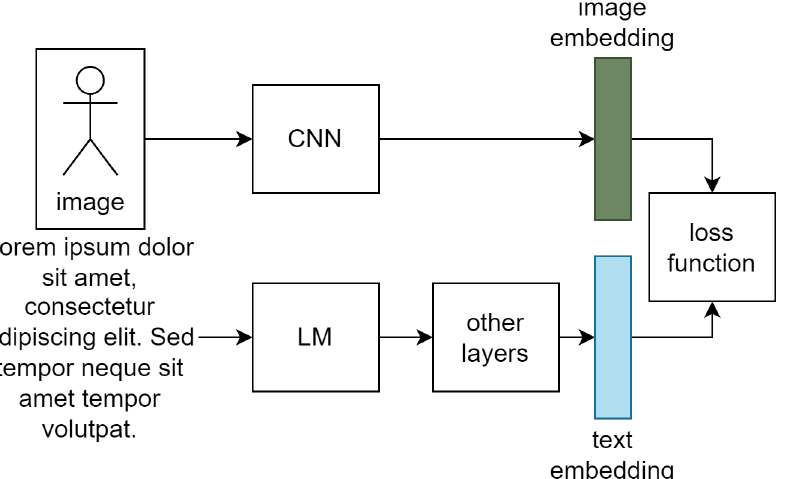
Figure 1. The general model structure for person description search. The top row is the image branch, and the bottom row is the text branch. The sub-model for the text branch is generally a CNN, while for the text branch, it is a large language model (the LM block) followed by additional layers. The output of each branch is chosen to be the same size so that some representation learning loss function can be used. In this work, we focus on the LM